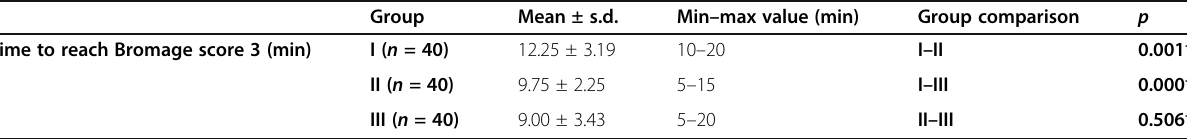
Table 3 Time to reach Bromage score 3 (min)